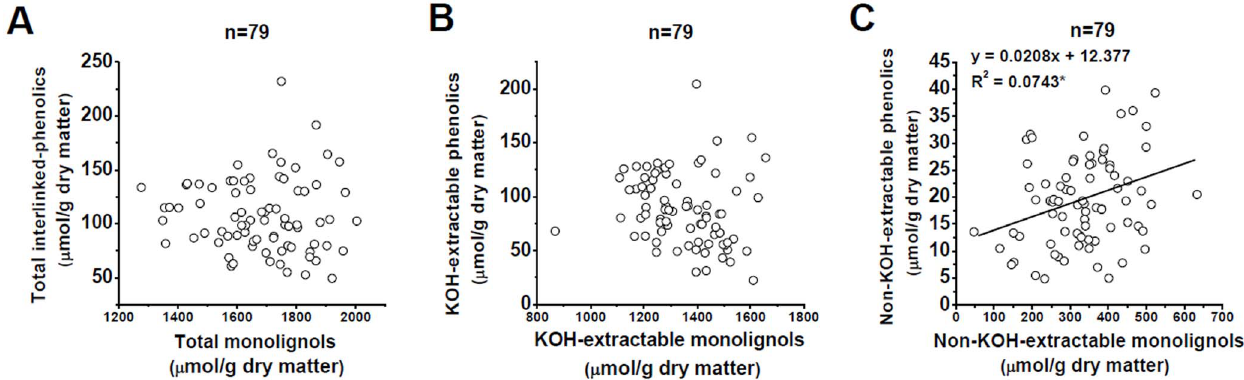
Figure 5. Correlation analysis between monolignols and interlinked-phenolics in Miscanthus . (A) Total monolignols and interlinked- phenolics; (B) The KOH-extractable monolignols and interlinked-phenolics; (C) The non-KOH-extractable monolignols and interlinked-phenolics. * Indicated the significant correlation coefficient value at p , 0.05, (n=79).